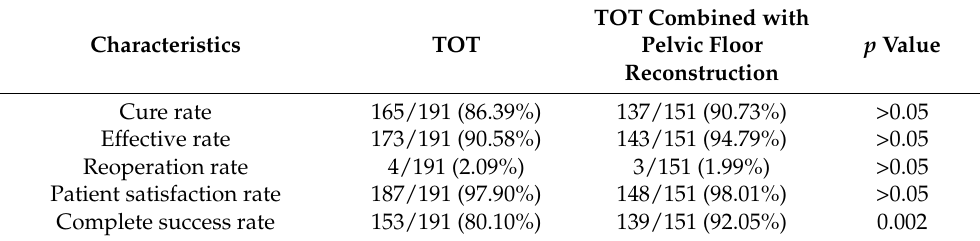
Table 3. Clinical